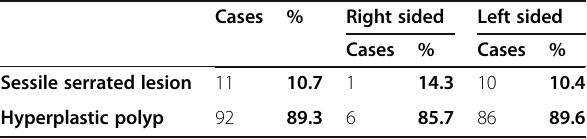
Table 2 Diagnosis after performing eight additional sections Cases % Right sided Left sided Cases